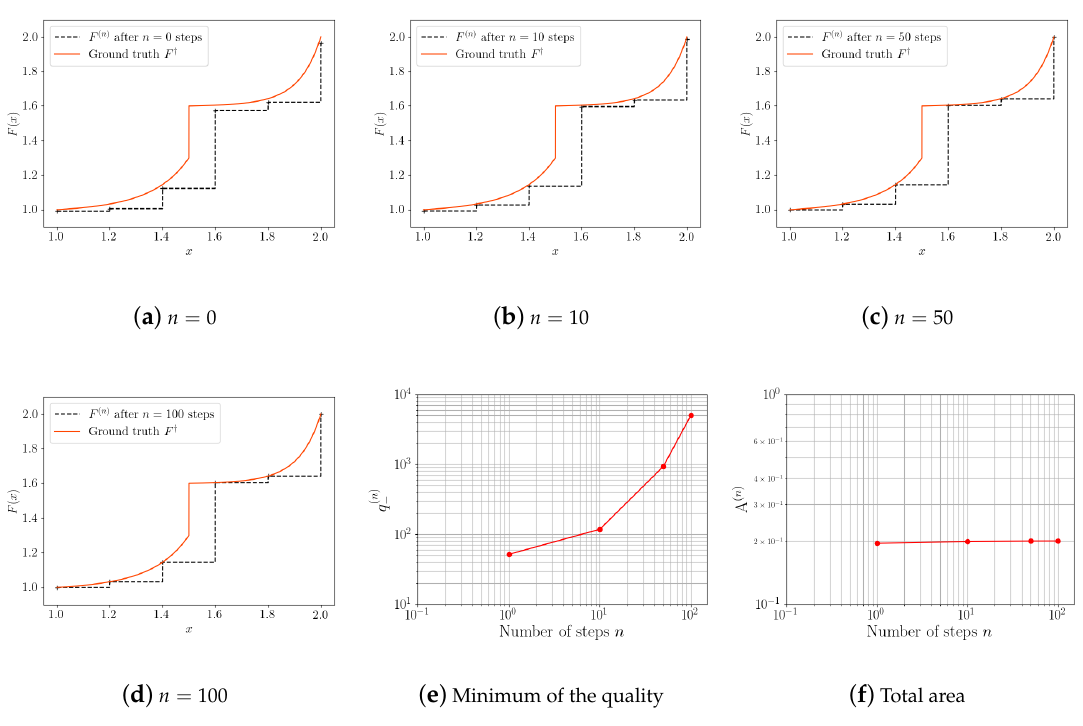
Figure 6. Evolution of F ( n ) and the minimum of the quality and the total area as functions of the iteration count, n , for a discontinuous ground truth F † with E = 10 4